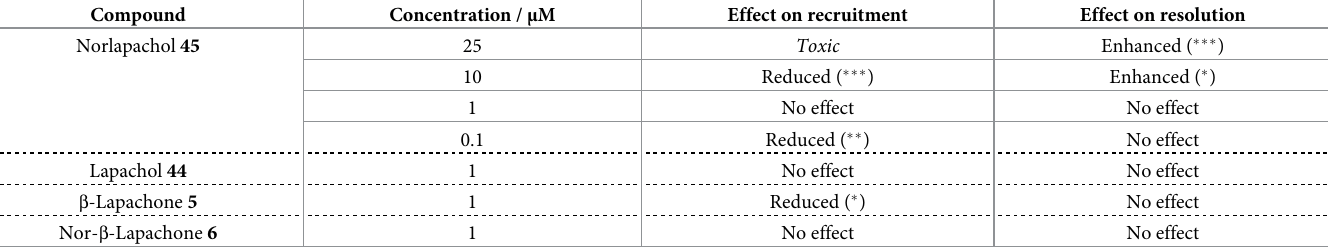
Table 2. Summary of the effects of norlapachol 45, lapachol 44, β -lapachone 5, and nor- β -lapachone 6 on neutrophil recruitment and resolution of inflammation in vivo